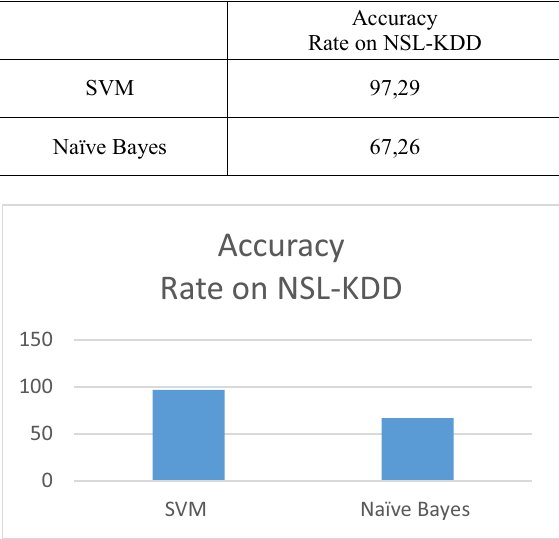
Fig. 8. Comparison of classifiers’ performance on NSL-